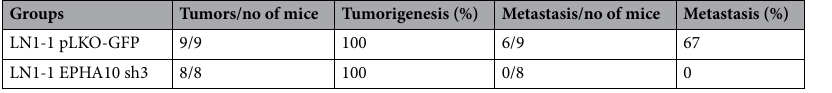
Table 1. Tumor formation and spontaneous lymph node metastases in mice injected with oral squamous cell carcinoma (OSCC) cells expressing EPHA10 shRNA or the vector control.